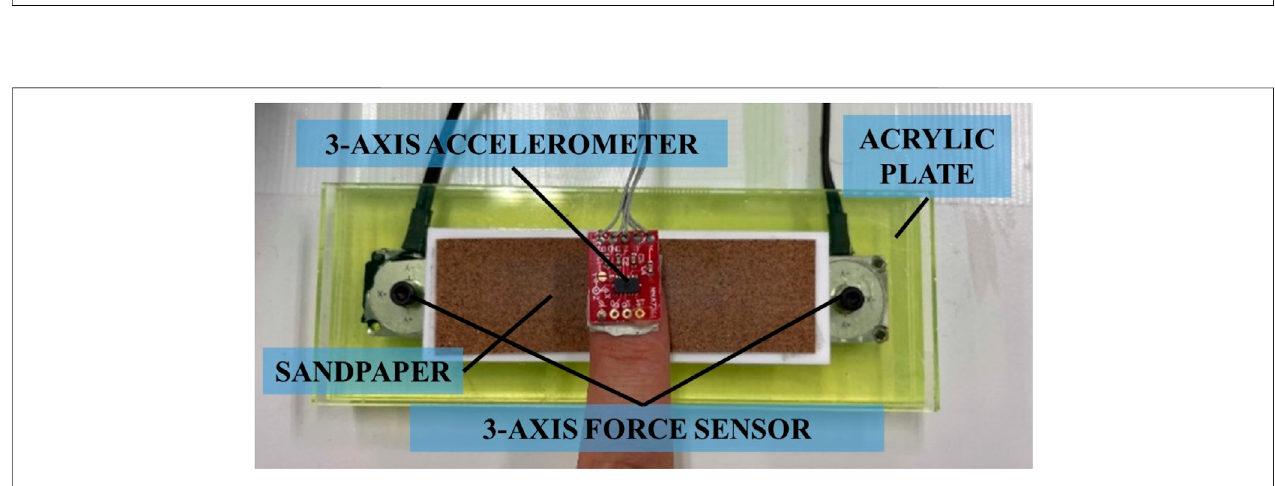
FIGURE2| Thespectrumsobtained whenprocessing thevibration ofsandpaper #100. Blue:Spectrumofthe 3Dmeasured displacement curve;Grey:Spectrum of the transformed acceleration curve; Orange: Spectrum of the acceleration curve after low-pass fi ltering; Yellow: Spectrum of the acceleration measured directly by accelerometer.